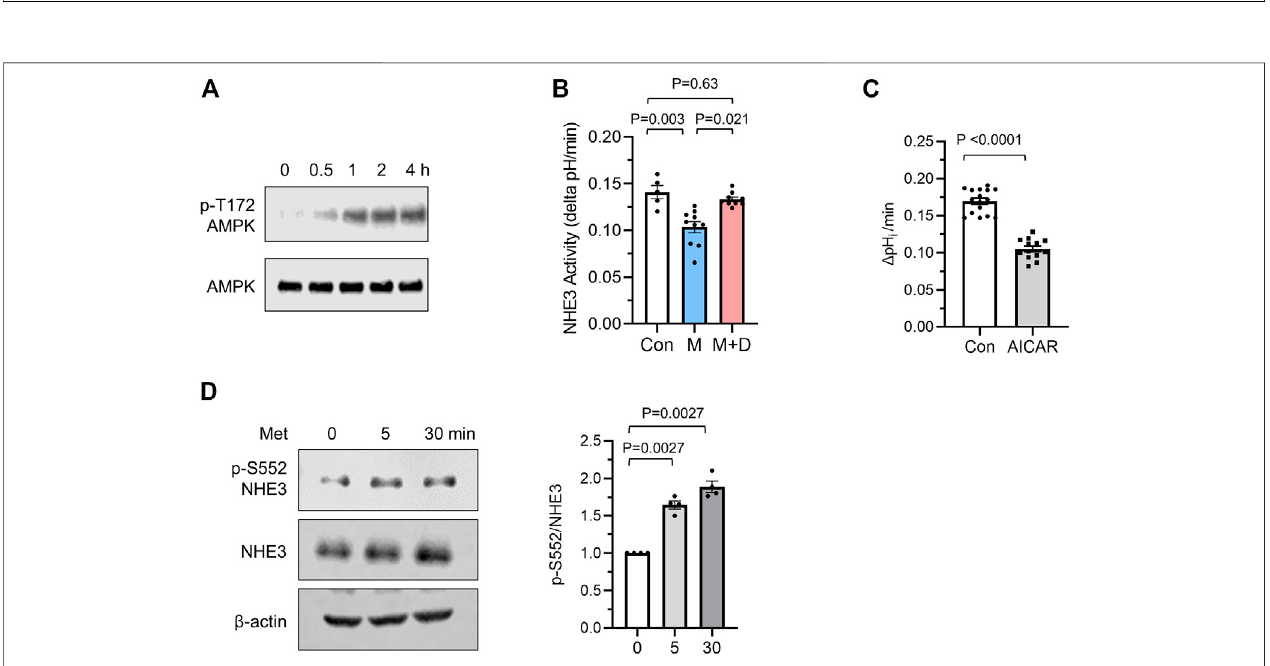
FIGURE 3| Metformin inhibits NHE3 activity. (A) Phosphorylation ofAMPK at Thr172 was determined in Caco-2bbe cells treated with 1 mM metformin. (B) NHE3 activities were determined in untreated control (Con) cells, and cells treated with metformin (M) or metformin + dorsomorphin (M + D). n = 10. Statistical analysis was performed by two-way ANOVA with Tukey ’ s post-hoc test. (C) NHE3 activities in control and AICAR treated cells are shown. n = 11. Statistical signi fi cance was determined by unpaired t -test. (D) NHE3 phosphorylation at Ser552 was determined using phospho-speci fi c antibodies. Cellular NHE3 and ß -actin were used as loading